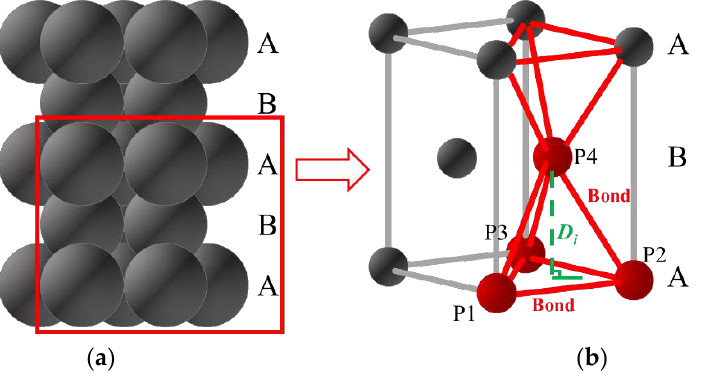
Figure 10. Hexagonal close-packed structure. ( a ) stack of particles in PFC 3D ( b ) simplified particle- bond model.